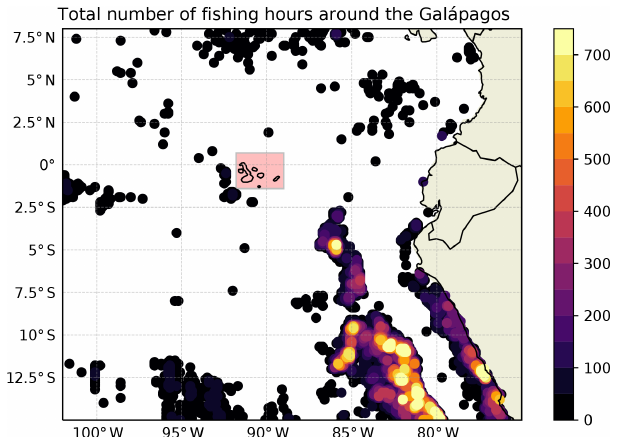
Figure 2. Map of locations where, according to the Global Fishing Watch dataset from Kroodsma et al. (2018), there was more than 24h of fishing effort. Circles are colour-coded to the total amount of fishing hours in the dataset. Red rectangle denotes the Galápagos region as used throughout this